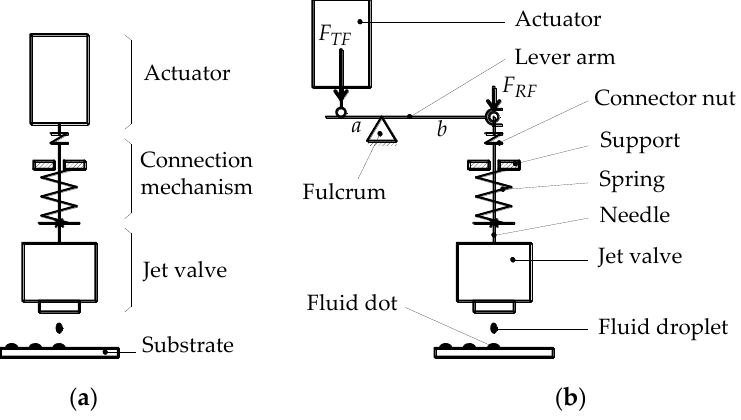
Figure 1. Jet dispenser models. ( a ) Direct actuating; and ( b ) lever arm and fulcrum structure.